Question: Briefly state, in one sentence, what is plotted here.
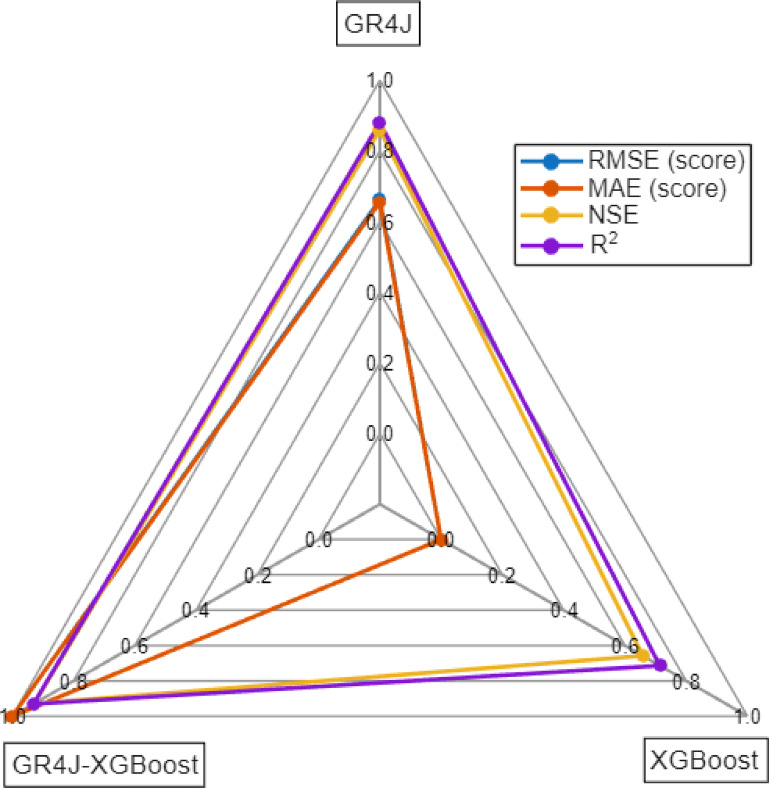
Answer: Spider plots of the runoff estimation models during the testing period. For visualization purposes, RMSE and MAE were converted into normalized performance scores (0–1), where higher values indicate better model performance.